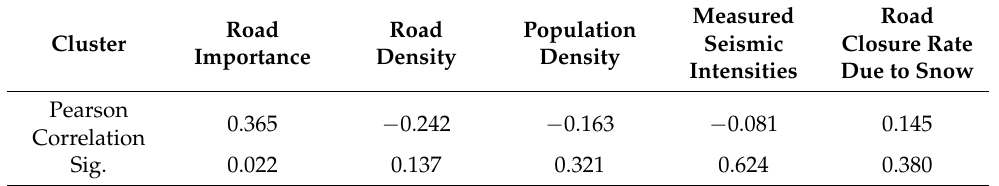
Table 12. Correlations between road restoration clusters and road elevation in Miyagi prefecture. Cluster Pearson Correlation